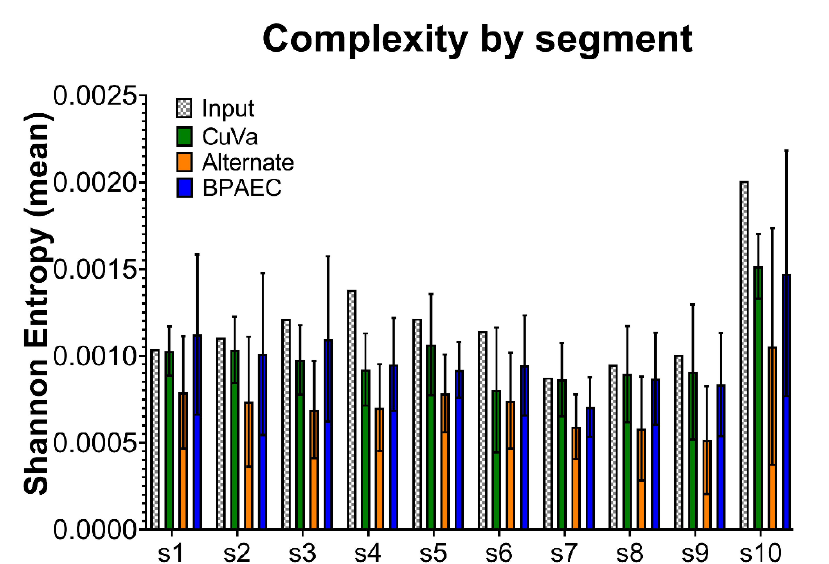
Figure 5. BTV Genetic Complexity by Segment across Cell Culture Conditions. Shannon entropy was calculated for each segment as a measure of viral population complexity. Segments 1–10 are represented along the x -axis (s1, s2, s3, s4, s5, s6, s7, s8, s9, and s10). For BTV17-CUVA, -ALT, and -BPAEC, mean Shannon entropy (and standard deviation) for each segment across passages 3, 6, and 9 are shown.